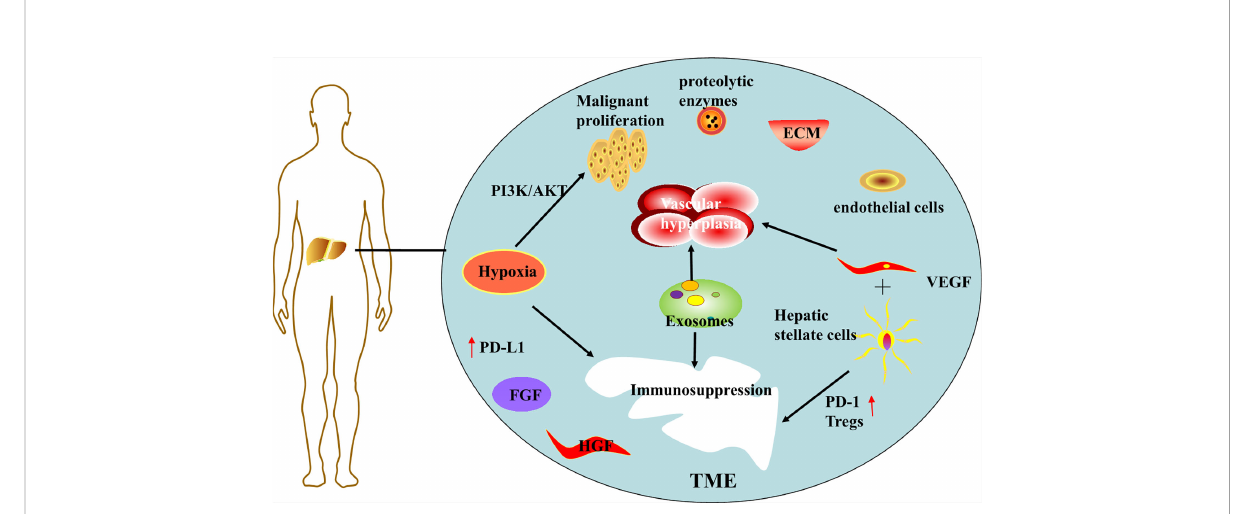
FIGURE 1 Schematic diagram of tumor microenvironment formation